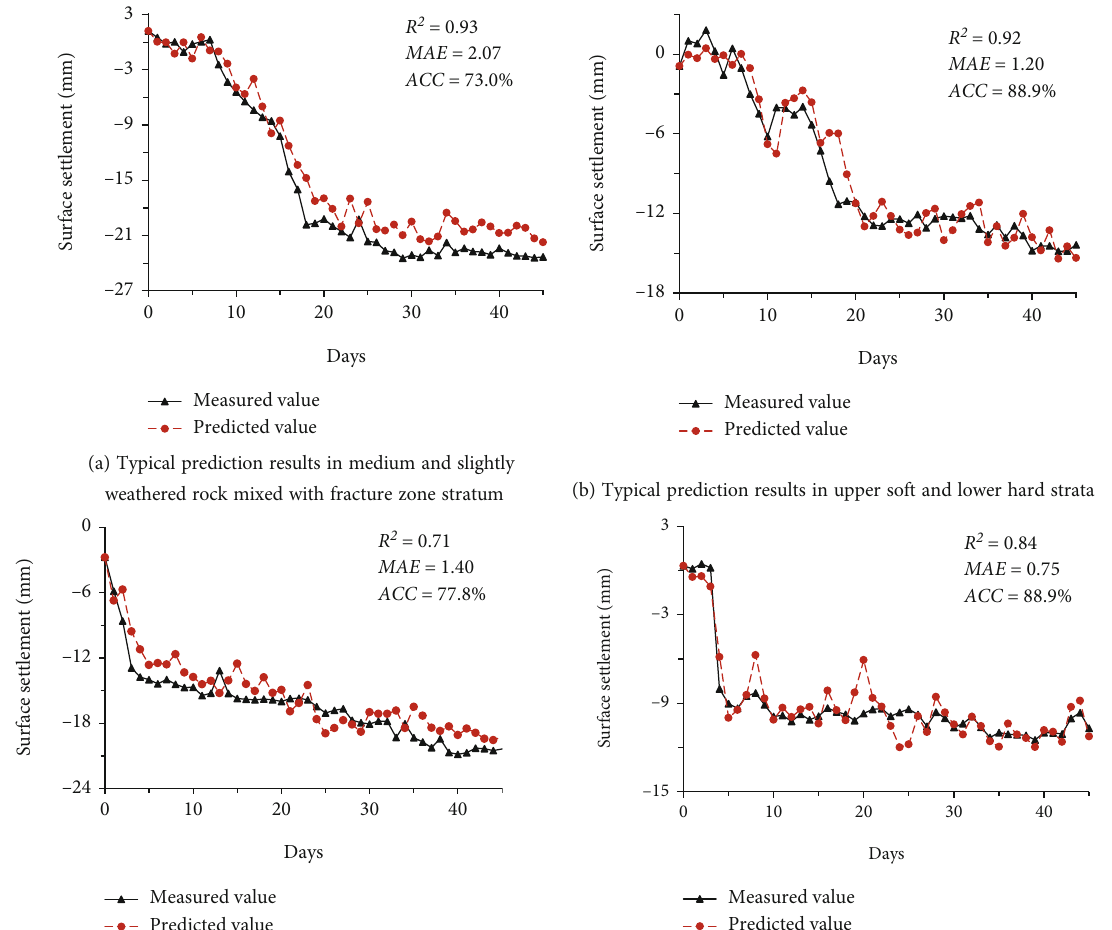
Figure 10: Comparison of typical prediction results of surface settlement development in di ff erent